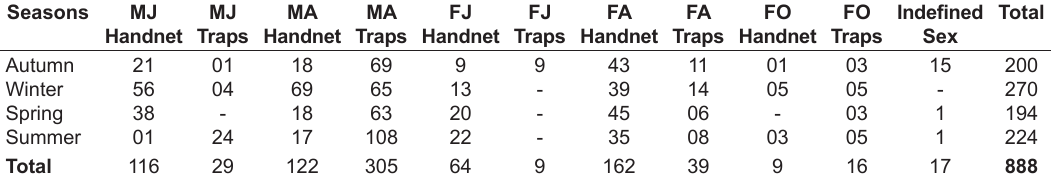
Table 1. Total number of individuals of Aegla manuinflata sampled with handnet and traps in the four seasons of the year ranging from May 2006 to April 2007 in the Passo Taquara stream, São Pedro do Sul, Rio Grande do Sul state, Brazil (MJ: Male juveniles, MA: Male adults, FJ: Female juveniles, FA: Female adults, OF: Ovigerous females).